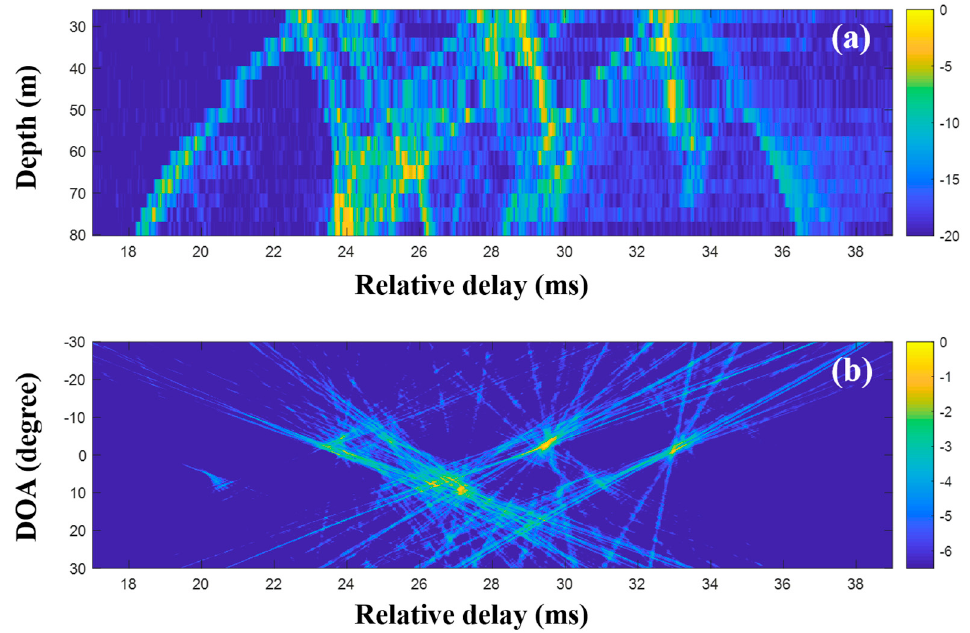
Figure 14. Direction-of-arrival (DOA) estimation using the matched filter (MF) with multiple snapshots captured by the vertical line array (VLA) in SAVEX15 (11–31 kHz): ( a ) arrival structures via the application of the MF to the signals at the VLA, and ( b ) DOAs using delay-and-sum beamforming with the arrival structures.